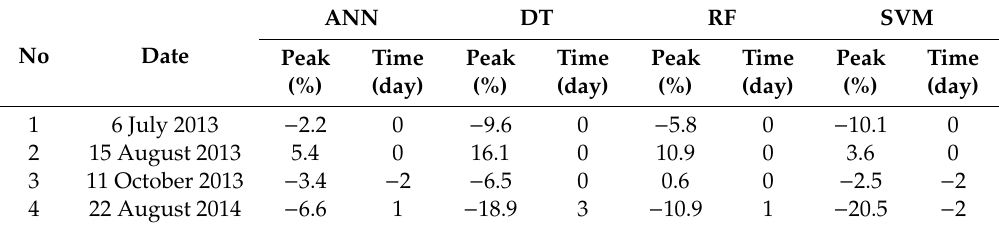
Table 5. Di ff erences between peak levels derived from the four machine learning (ML) techniques and observation.